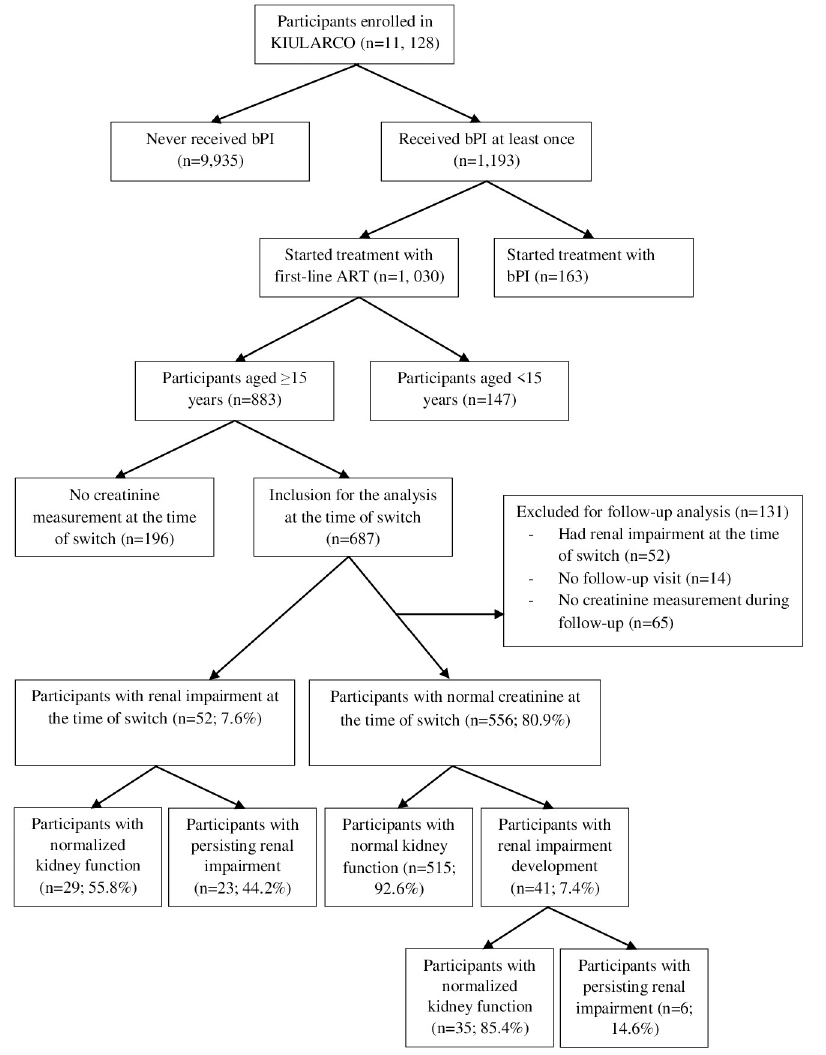
Fig 1. Participants’ flow chart.